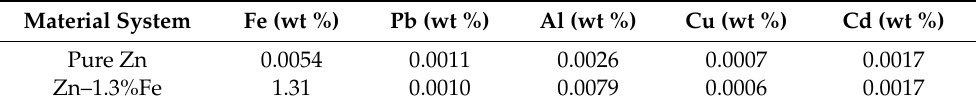
Table 1. Chemical composition of pure Zn and Zn–1.3%Fe